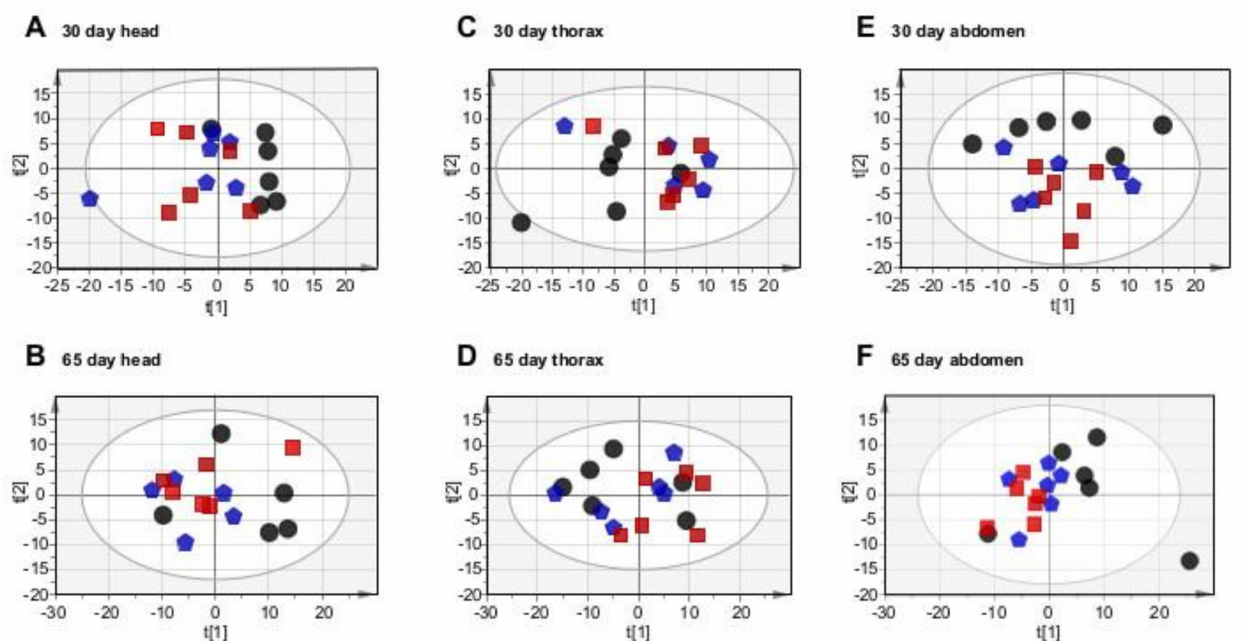
Figure 3. PCA analysis, UV scaling by anatomical region and age. ( A ) PCA score plot of head extracts (30 days), 6 components, head R2X (cum) = 0.67, Q (cum) = 0.25. ( B ) PCA score plot of head extracts (65 days), 6 components, head R2X (cum) = 0.61, Q (cum) = 0.27. ( C ) PCA score plot of thorax extracts (30 days), 3 components, head R2X (cum) = 0.9, Q (cum) = 0.28. ( D ) PCA score plot of thorax extracts (65 days), 4 components, head R2X (cum) = 0.61, Q (cum) = 0.37. ( E ) PCA score plot of abdomen extracts (30 days), 3 components, head R2X (cum) = 0.64, Q(cum) = 0.29. ( F ) PCA score plot of abdomen extracts (65 days), 4 components, head R2X (cum) = 0.65, Q (cum) =